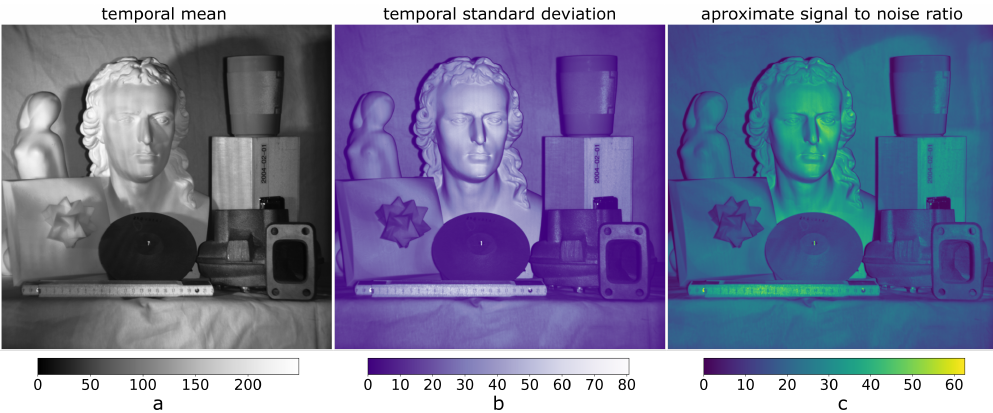
Figure 9. ( a ) mean of 400 images with changing projected pattern. Note the inhomogeneous ambient light coming from the left and the shadows thrown by it on the background farbic. ( b ) temporal standard deviation of the same images. Note the absence of the (temporally constant) ambient light. ( c ) approximated signal to noise ratio (ASNR). Note the negative influence of the ambient light on the ASNR value on the background fabric.